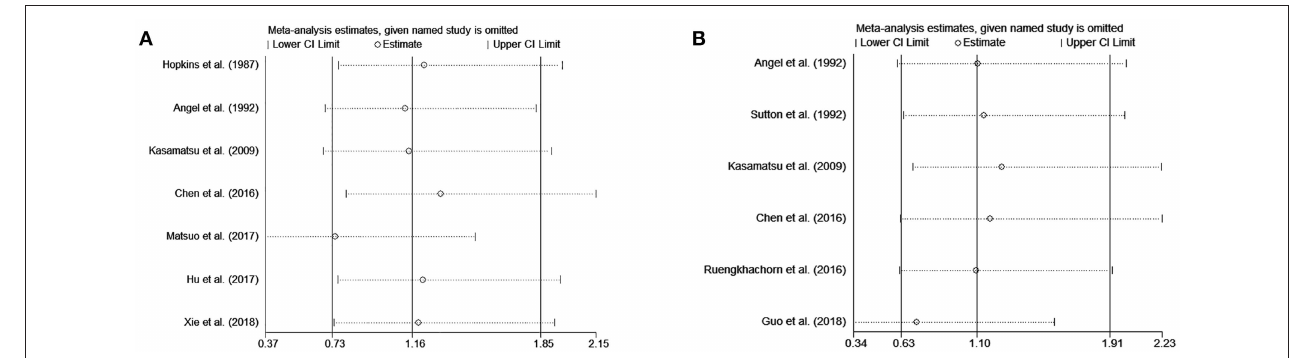
FIGURE 8 | Sensitivity analysis of OS (A) and PFS (B) show that no significant changes in the final result after each study was omitted sequentially.